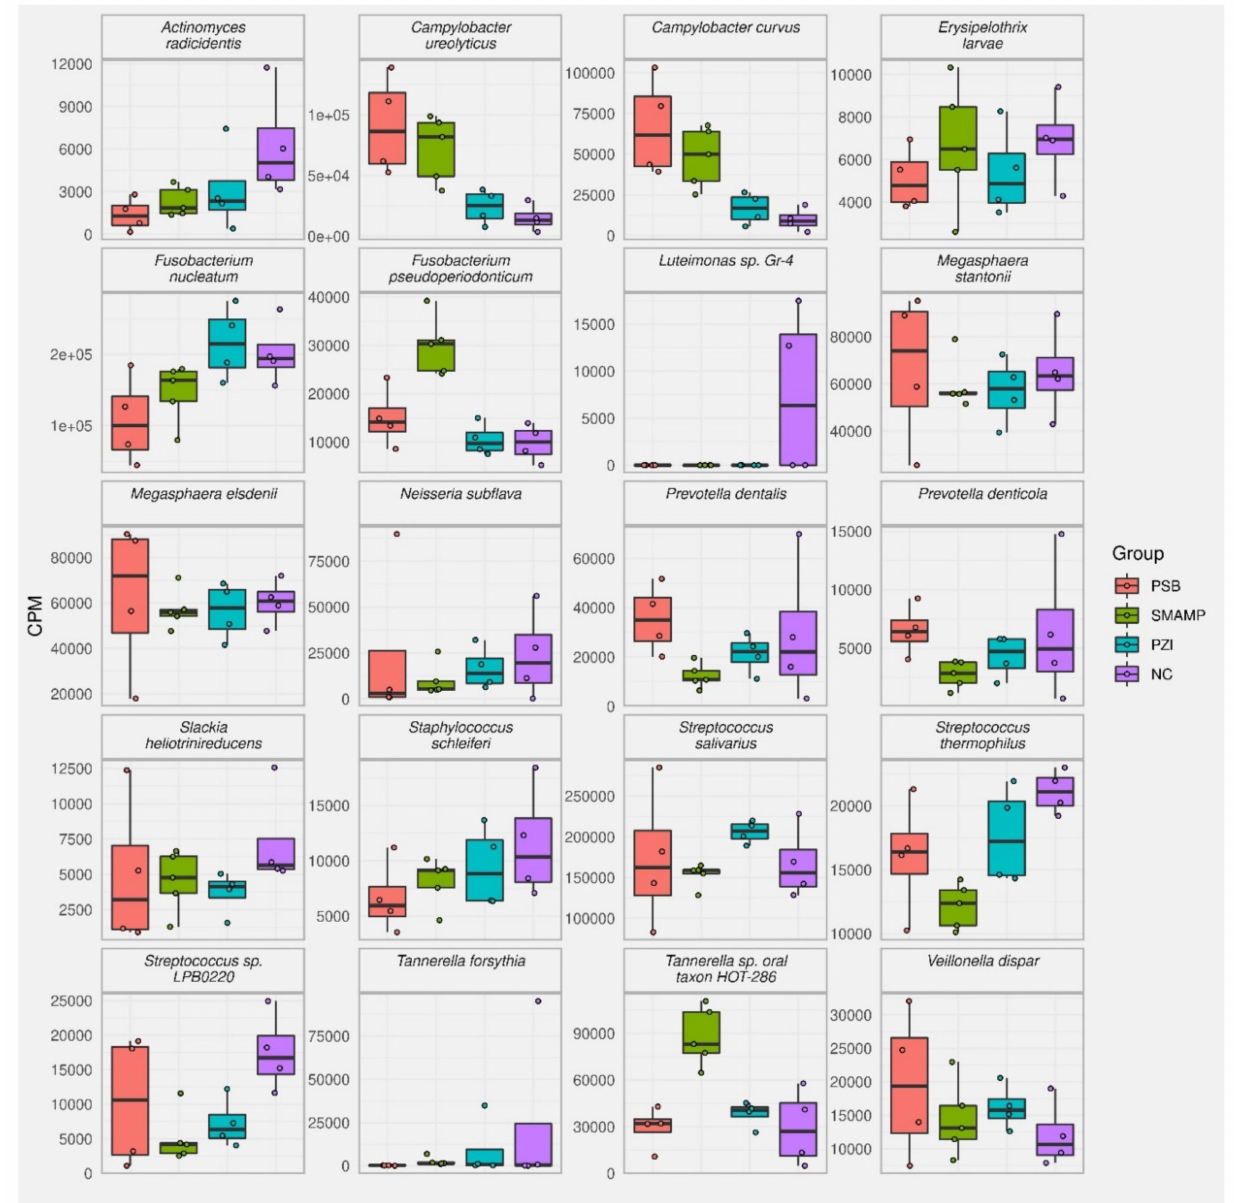
Figure 6. Top 20 most abundant bacterial species, presented as CPM, for bacteria harvested from native biofilms grown on uncoated substrates ( NC , purple), and bacteria harvested from biofilms grown on polymer-coated substrates ( PSB , red; PZI , turquois; SMAMP ,